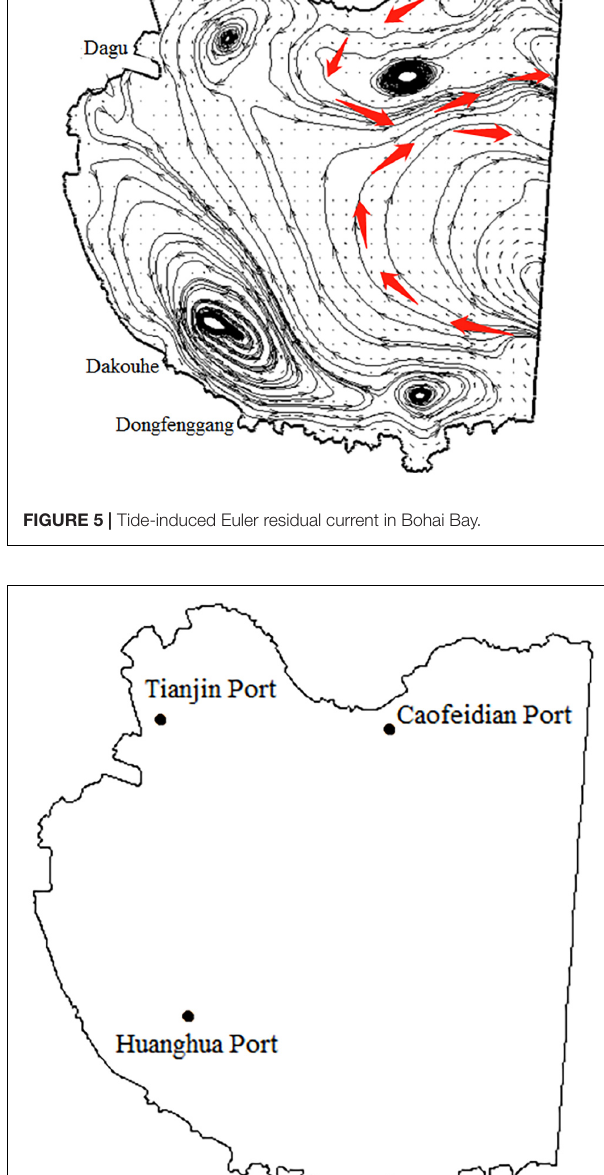
area of Bohai Bay. In Tianjin port, the particles released mainly diffuse around the port in the simulation time, and the motion track basically covers the area of Tianjin port. After being released in Huanghua port, the particles move back and forth with the longshore current, and they mainly diffuse along the coast and move to the northwest of Bohai